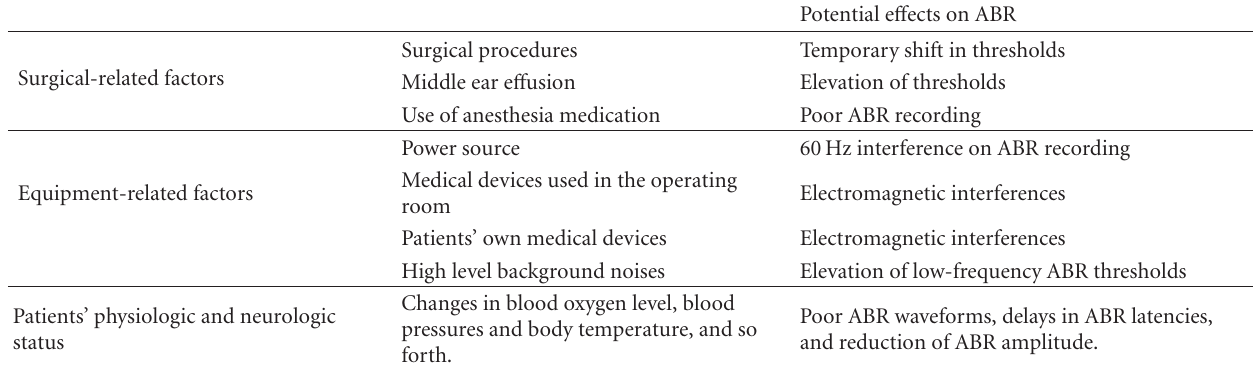
Table 5: Potential factors a ff ecting ABR outcomes in the operating